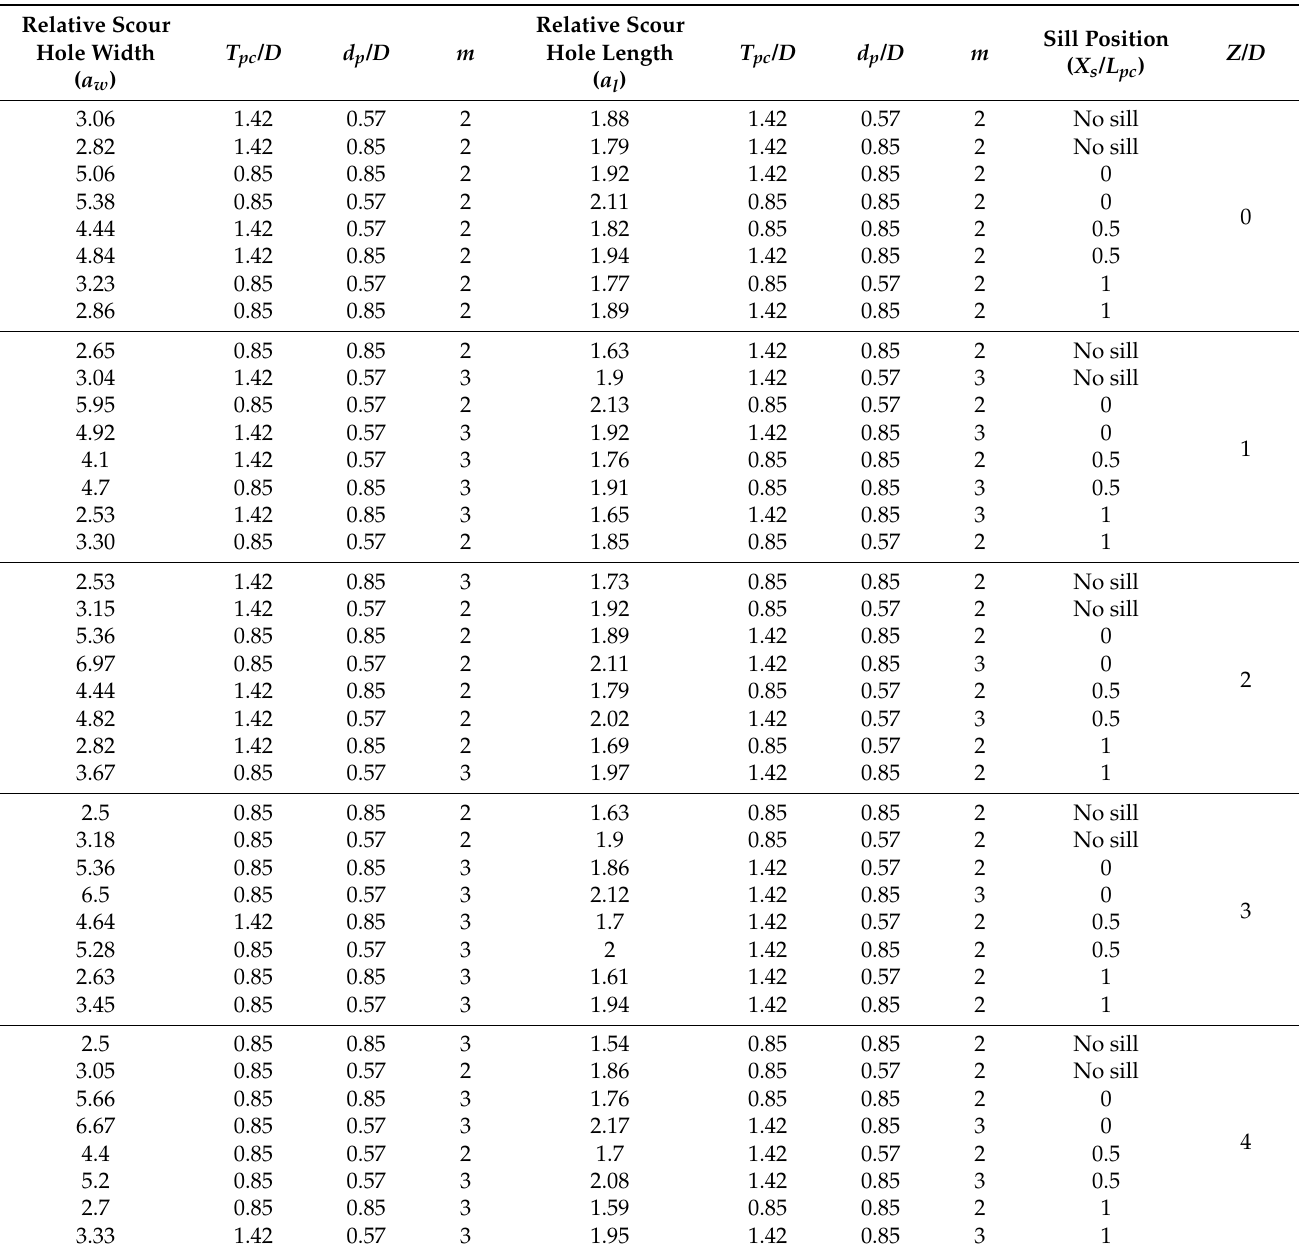
Table 2. Maximum and minimum values of the scour hole